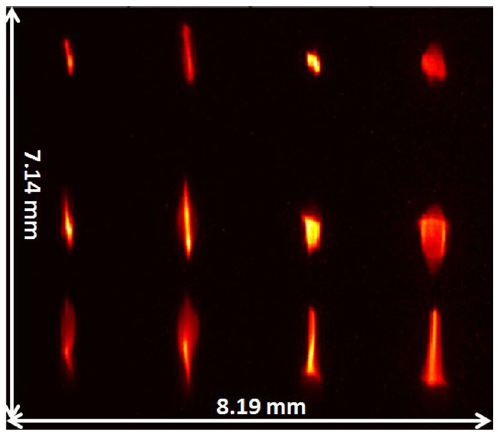
FIG. 5. Emittance measurement in the horizontal plane on screen D1.